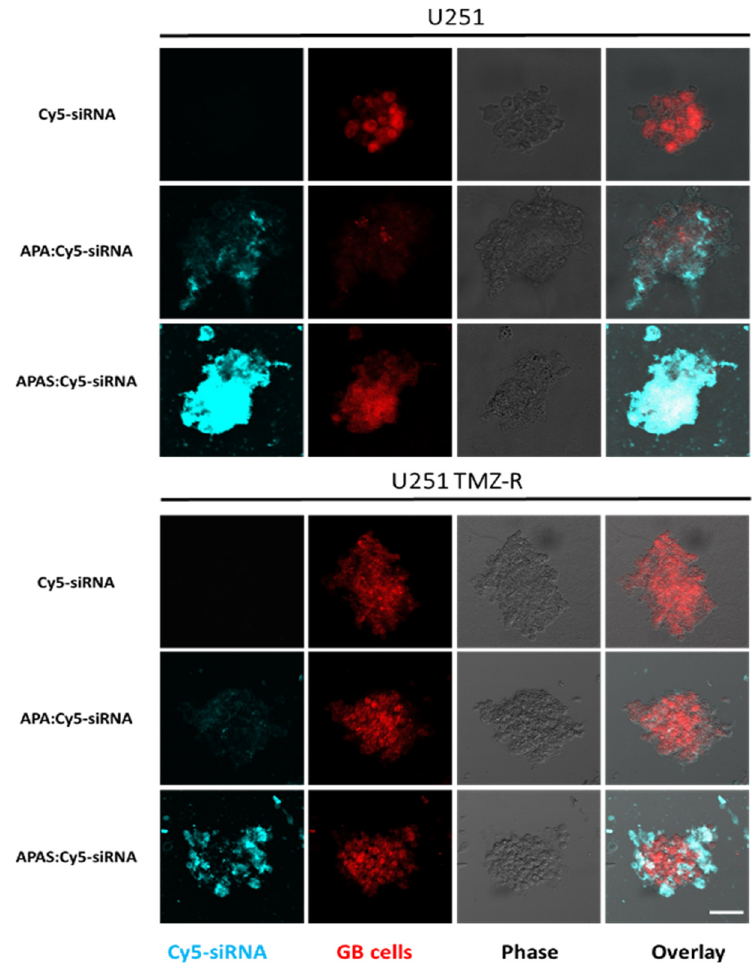
Figure 7. Sulfonate modification of APA facilitated internalization of Cy5-siRNA carrying poly- plexes into both U251 and U251 TMZ-R spheroids (scale = 50 µm).